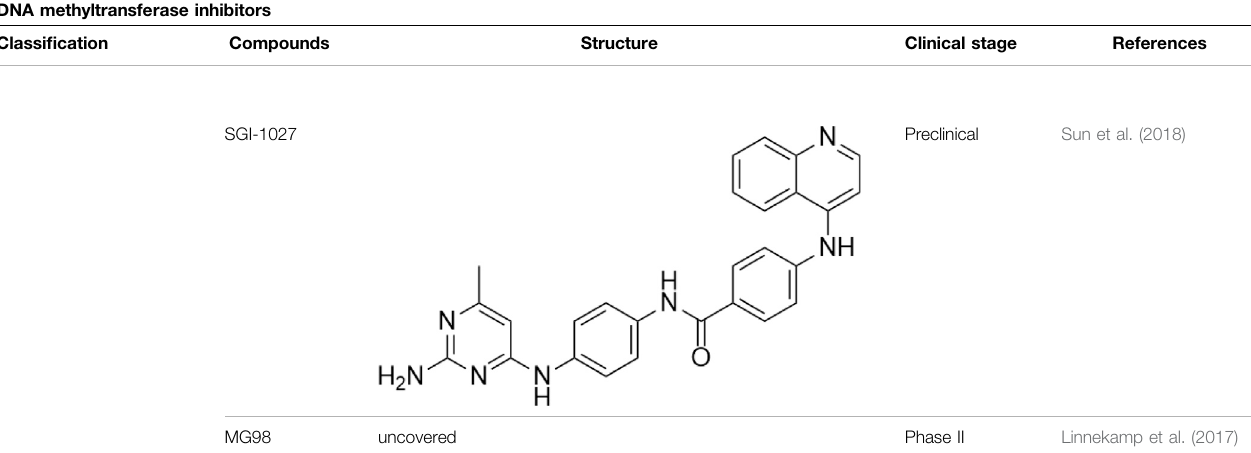
DNA methyltransferase